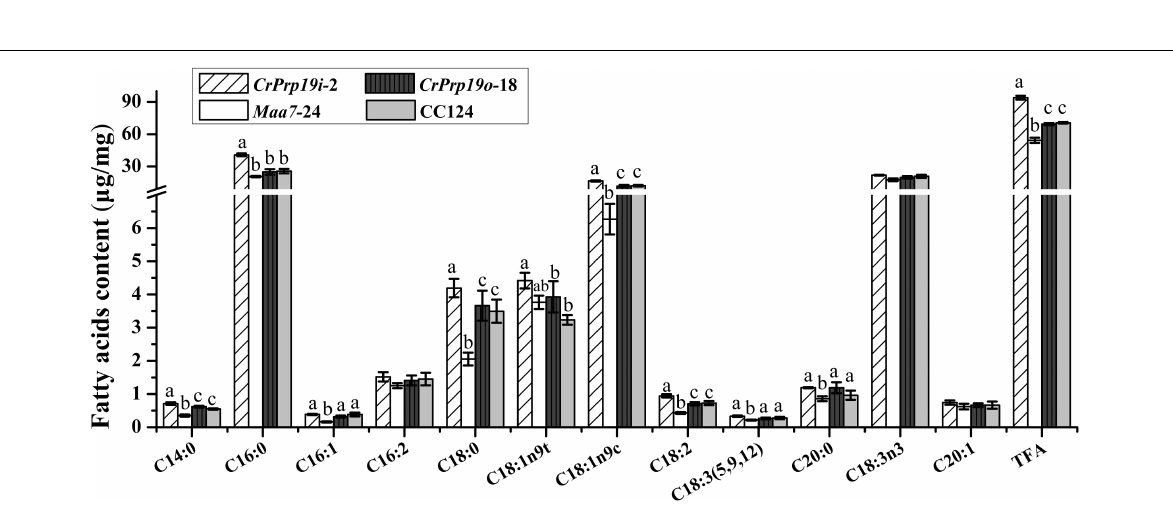
FIGURE 6 | Fatty acid composition in CrPrp19 RNAi and overexpression lines. FAMEs in transformant CrPrp19 i-2, CrPrp19 o-18, and controls were analyzed using GC-MS. TFA is total fatty acids. Each value represents mean ± SD ( n = 3). Significant difference between transformant CrPrp19 i-2, CrPrp19 o-18, and controls by one-way ANOVA is indicated with different